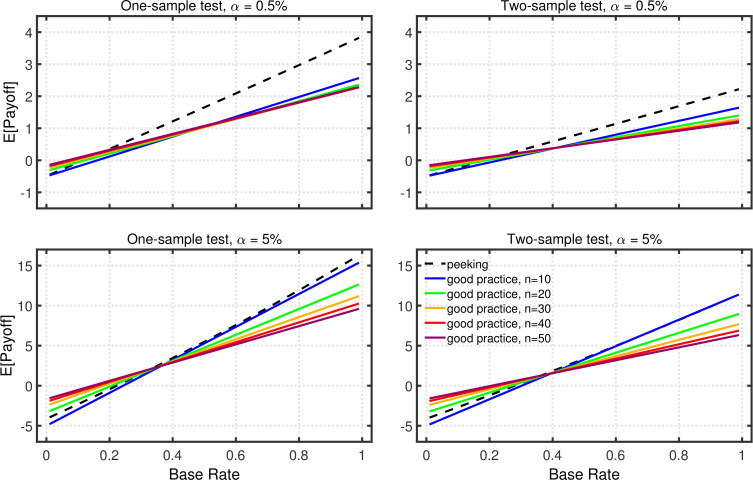
Expected payoff as a function of base rate and sample size.The dashed lines give the expected payoffs for researchers using data peeking at sample sizes of 10, 15, 20, 25, and 30. The solid lines give the expected payoffs for researchers who act in accord with good scientific practice and only check the data once, at the indicated sample size. The panels on the left side reflect the results for one-sample tests, whereas those on the right for two-sample tests. The upper and lower panels give the results for a nominal one-tailed α levels of 0.5 and 5%, respectively, with different vertical scales used because of the different ranges of payoffs for the two α levels. All results are based on an effect size of d=0.2, individual outcome payoffs of 𝒫t⁢p=1, 𝒫f⁢p=-1, 𝒫t⁢n=0, and 𝒫f⁢n=0, and a total sample size of nm⁢a⁢x=1,000. The results are similar for two-tailed testing (not shown).